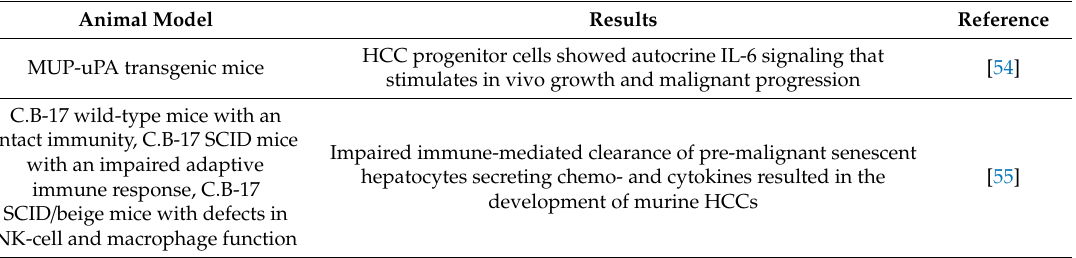
Table 1. Experimental evidence linking inflammation to HCC